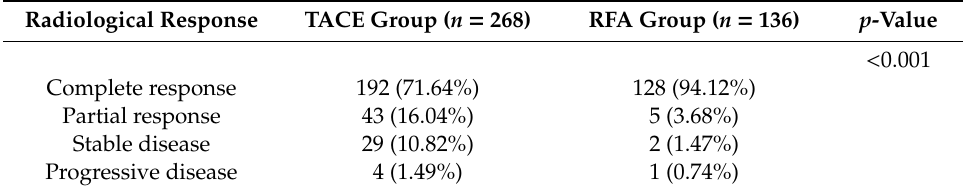
Table 2. Radiological response according to the treatment modality in the entire population. Radiological Response